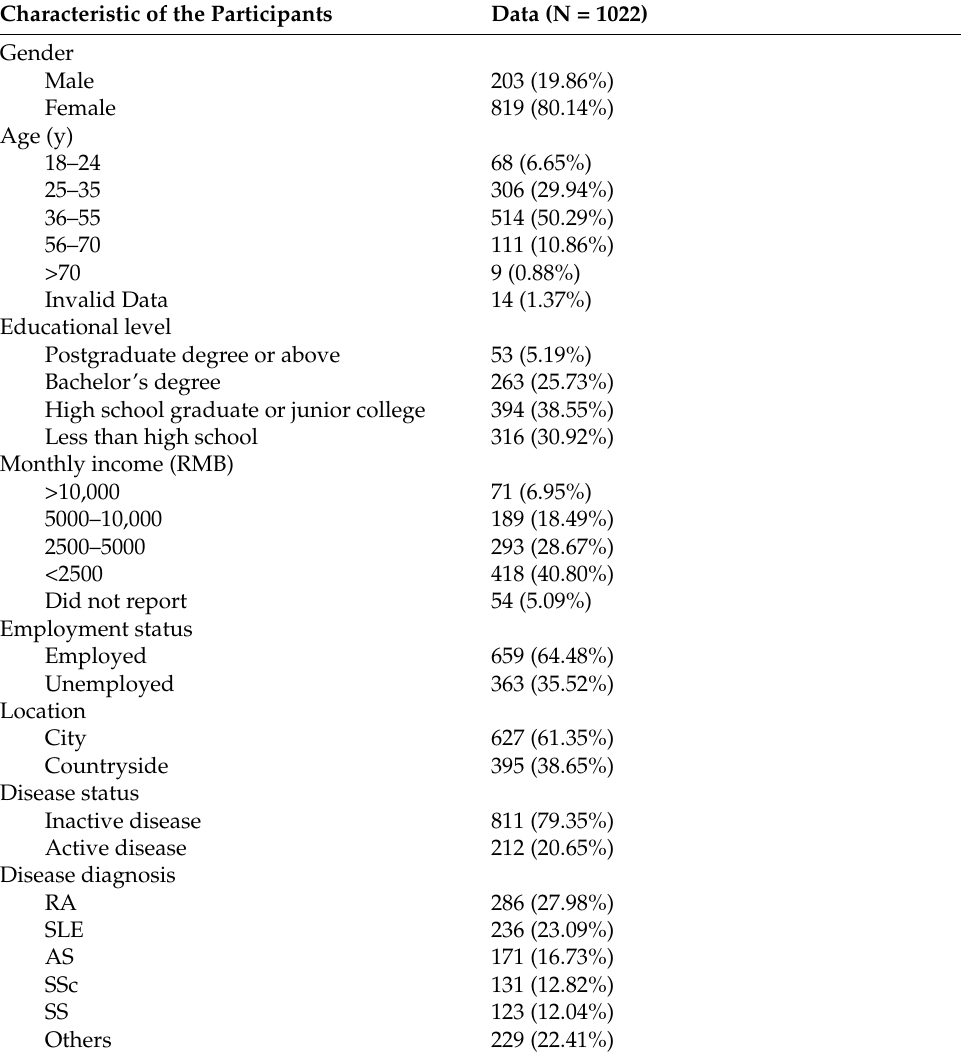
Table 1. Demographic data of the